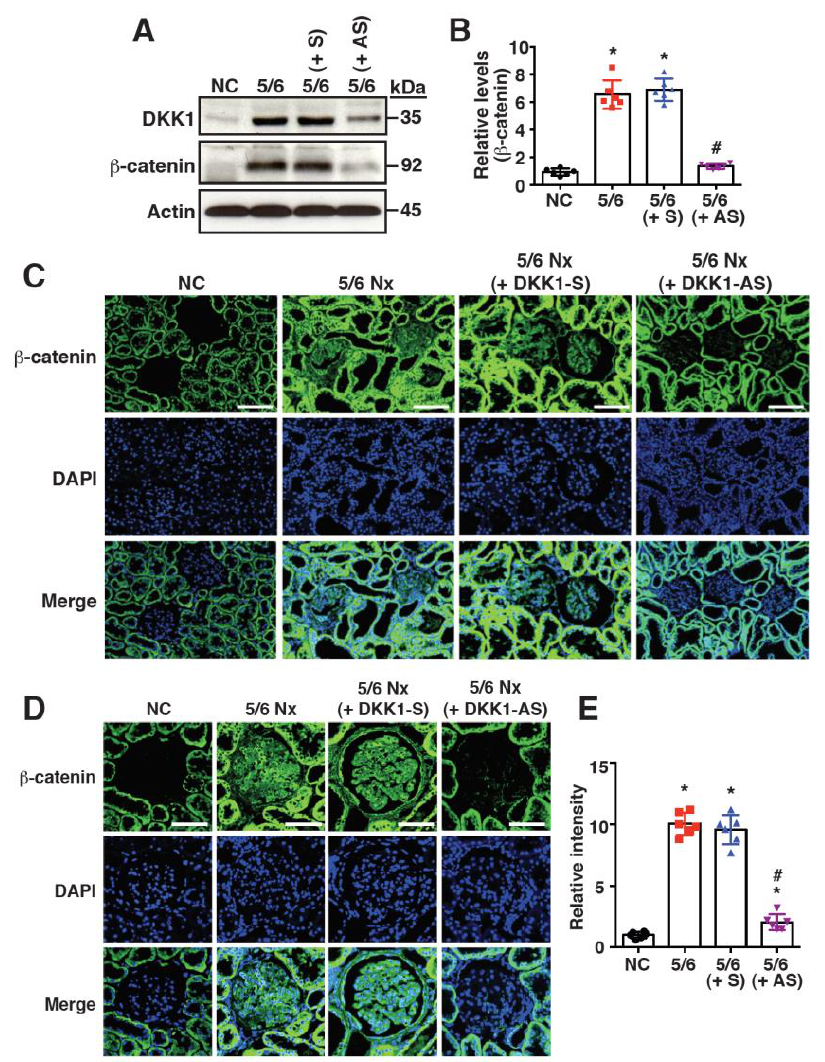
Figure 4. The renal expression of DKK1 positively correlates with accumulation of β -catenin in 5/6 Nx rats. ( A ) Representative images of Western blot analysis for the expression of DKK1 and β -catenin in renal tissues of the sham group and the 5/6 Nx groups that were untreated or treated with DKK1-S or DKK1-AS. ( B ) Quantitative analysis of Western blots for β -catenin in renal tissues of different groups (n = 6 for each group). * p < 0.05 versus the sham group, # p < 0.05 versus the untreated 5/6 Nx group. ( C ) Immunofluorescence analysis of β -catenin in kidney sections from the sham-operated rats and the 5/6 Nx rats left untreated or treated with DKK1-S or DKK-AS. Scale bars: 100 µ m. ( D ) Immunofluorescence images of renal glomeruli stained for β -catenin in different treated groups. Scale bars: 50 µ m. ( E ) Quantification of relative fluorescence intensities for β -catenin in renal glomeruli of different groups (n = 6 for each group). * p < 0.05 versus the sham group, # p < 0.05 versus the untreated 5/6 Nx